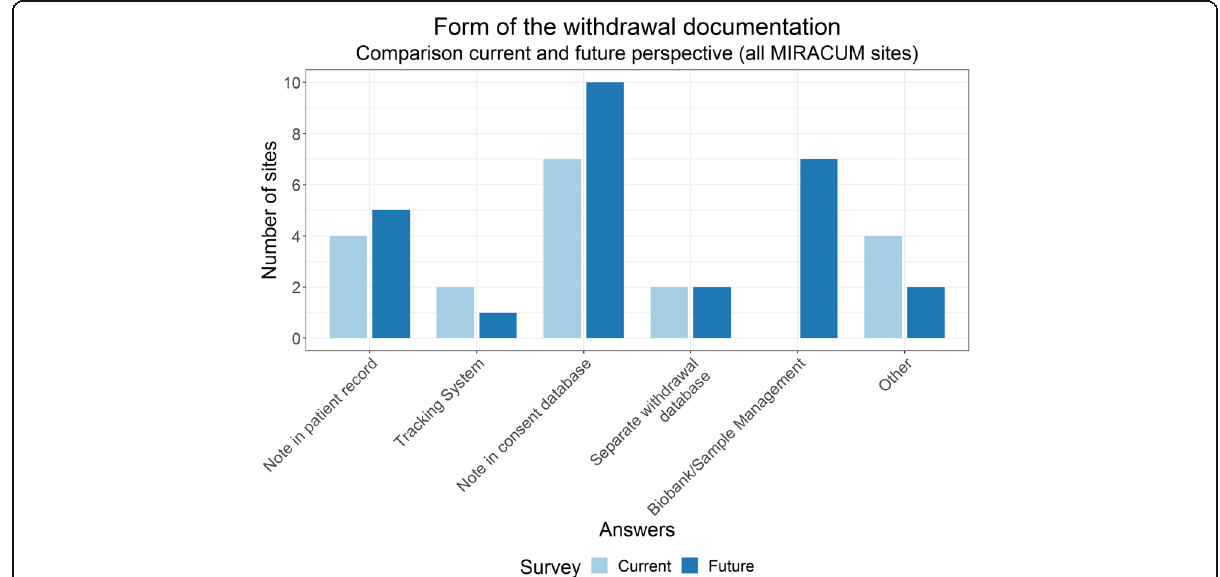
Fig. 6 Form of the withdrawal documentation. Frequency distribution of how withdrawals are documented currently and in future